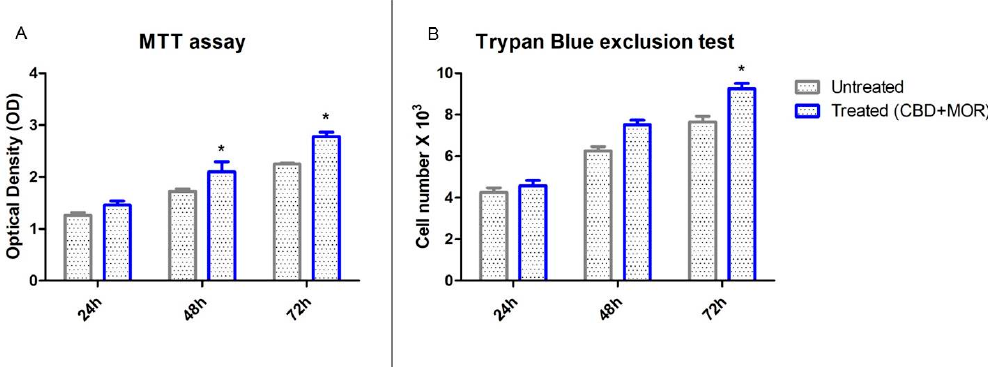
Figure 2. Cell viability assays. ( A ) Viability rate of untreated and treated (CBD+MOR) hPDLSCs at different endpoint (24, 48, and 72 h) evaluated using MTT assay. Data are expressed as the mean of optical density. ( B ) Viability, as determined by Trypan Blue exclusion, of treated and untreated hPDLSCs. Data are expressed as the mean ( n = 3) number of cells with 95% confidence limits. * p < 0.05.